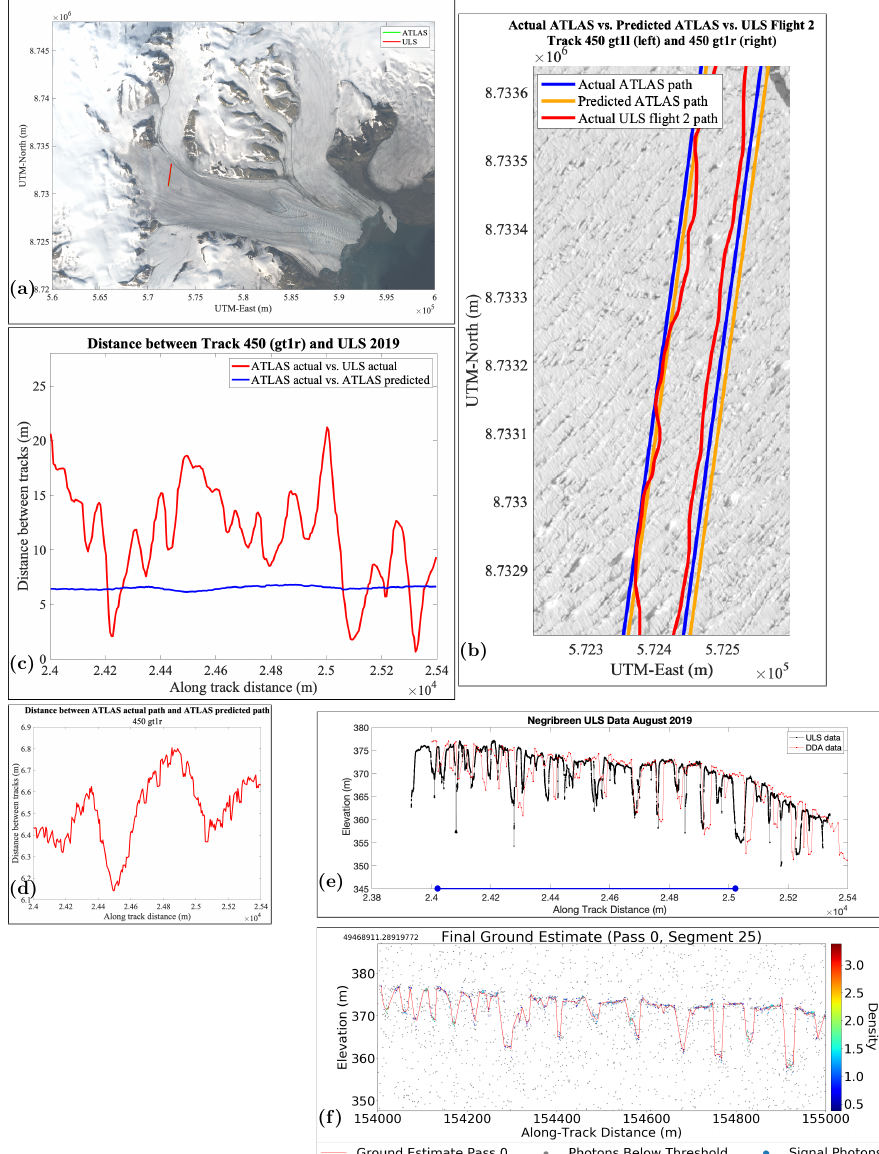
Figure 11. ICESat-2 ATLAS vs. ULS data. Track repeat accuracy and results. RGT 450, gt1r (weak). Negribreen validation campaign. Flight 2, 13 August 2019. ( a ) Location of DDA segments over Negribreen and closest ULS data (note the tracks are so close that the green line disappears under the red line). For segment numbering, see Figure 9 (ATLAS DDA segments).